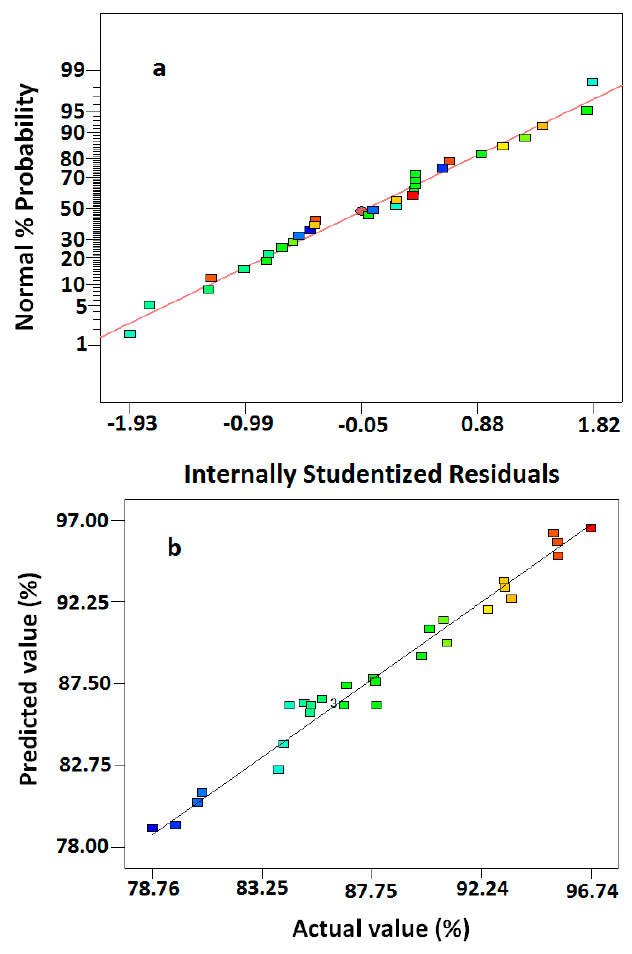
Figure 2. ( a ) The residual plot of runs from central composite rotatable design; ( b ) scatter plot of predicted conversion% value versus actual conversion% value. predicted conversion% value versus actual conversion%